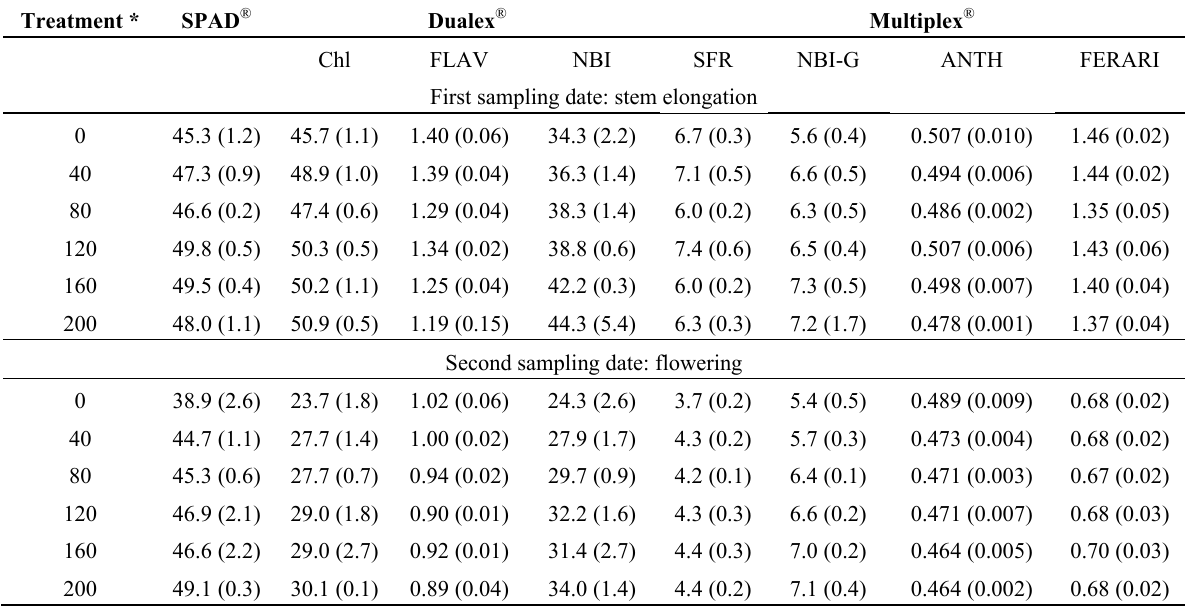
Table 3. Ground-level sensor indices obtained on two different sampling dates for the various N application treatments. Values expressed as the mean (standard